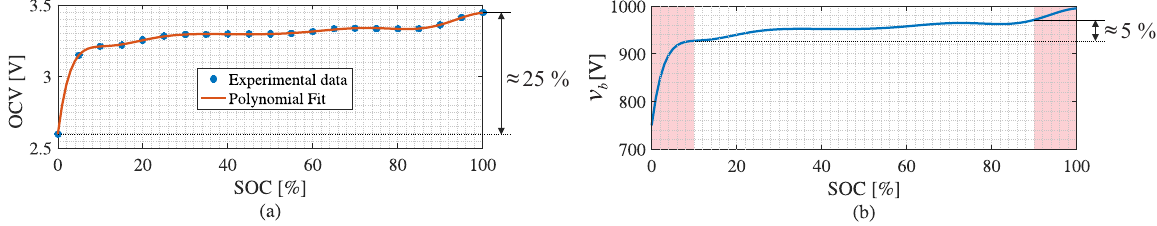
Figure 4. Open-circuit voltage characteristics: ( a ) single LIB cell experimental data from [39] and polynomial fitting; ( b ) curve of the LIB rack.